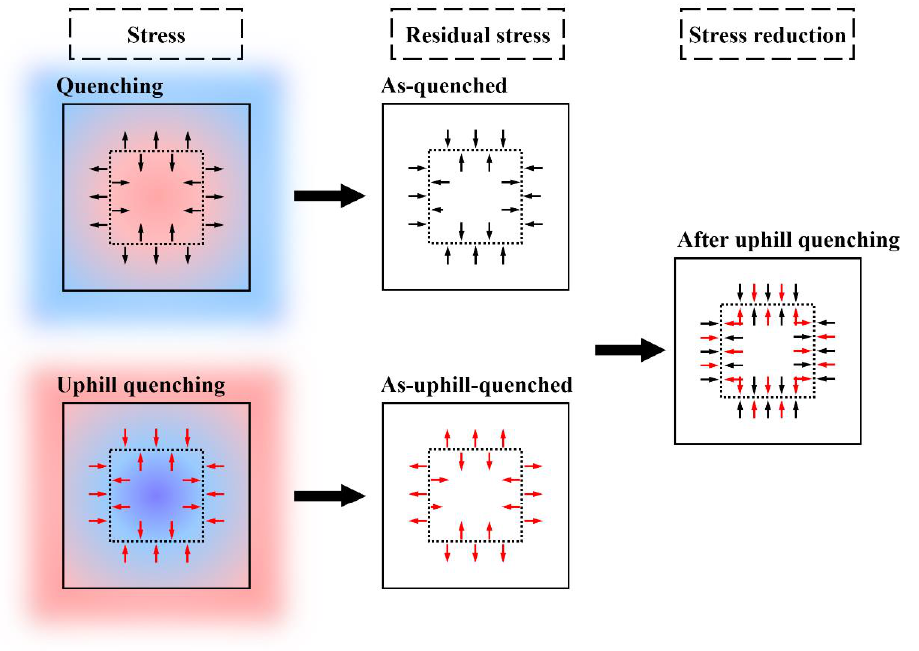
Figure 11. Stress field variation of a plate during the initial quenching process and the subsequent uphill quenching process.